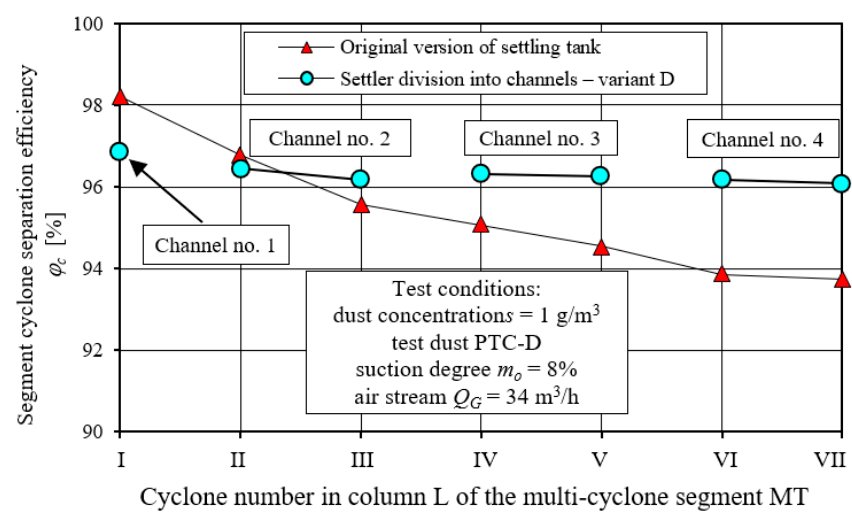
Figure 21. Separation efficiency values for single cyclones of left column (L) in MT multi-cyclone segment for the original version of the settler and after division into suction channels–variant D of settling tank.